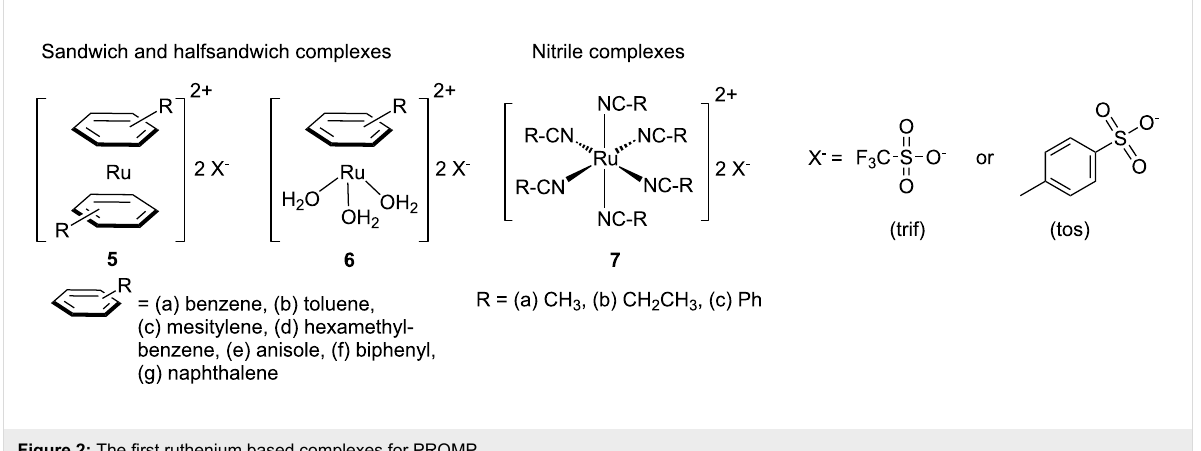
Figure 2: The first ruthenium based complexes for PROMP.